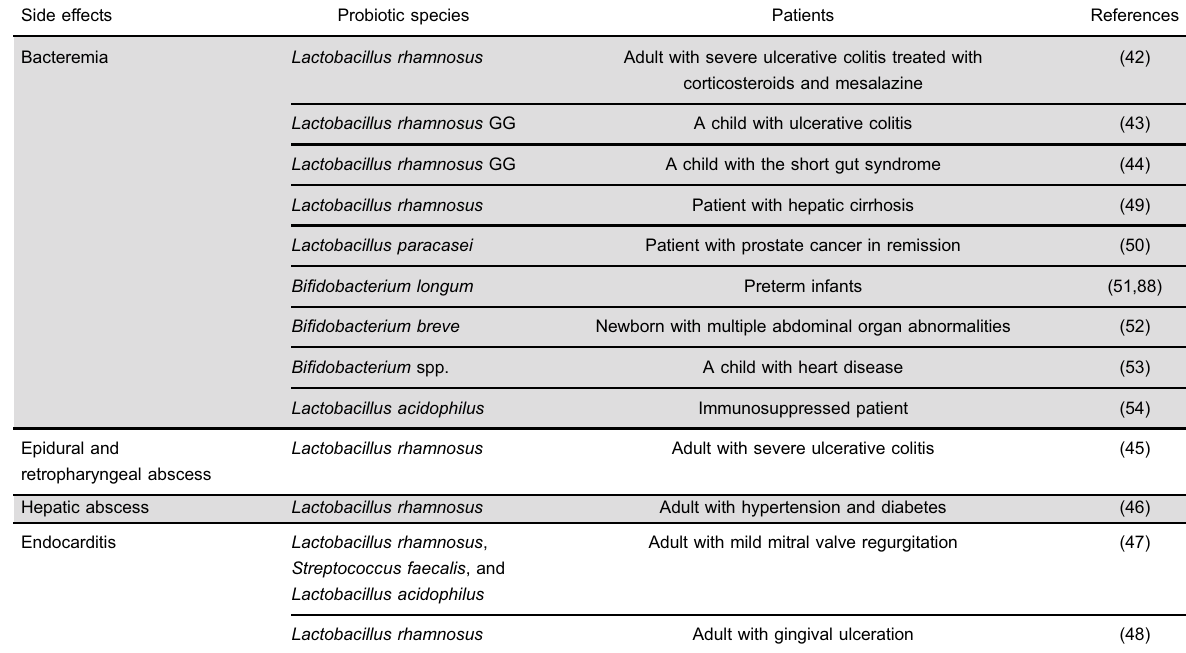
Table 2. Probiotics-related side